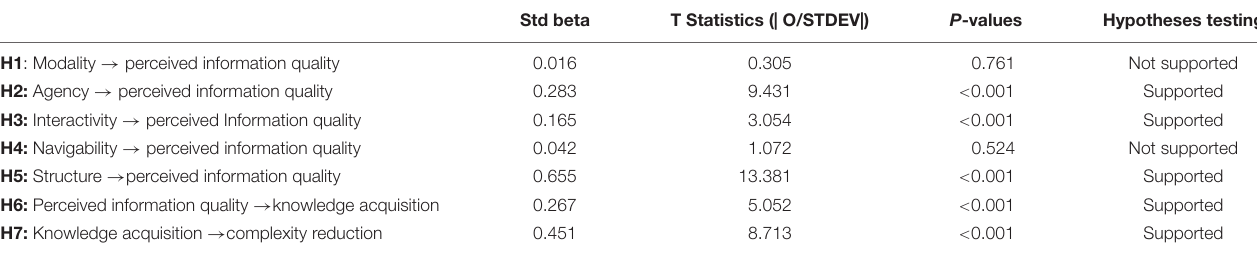
TABLE 4 | Construct relationship and hypotheses